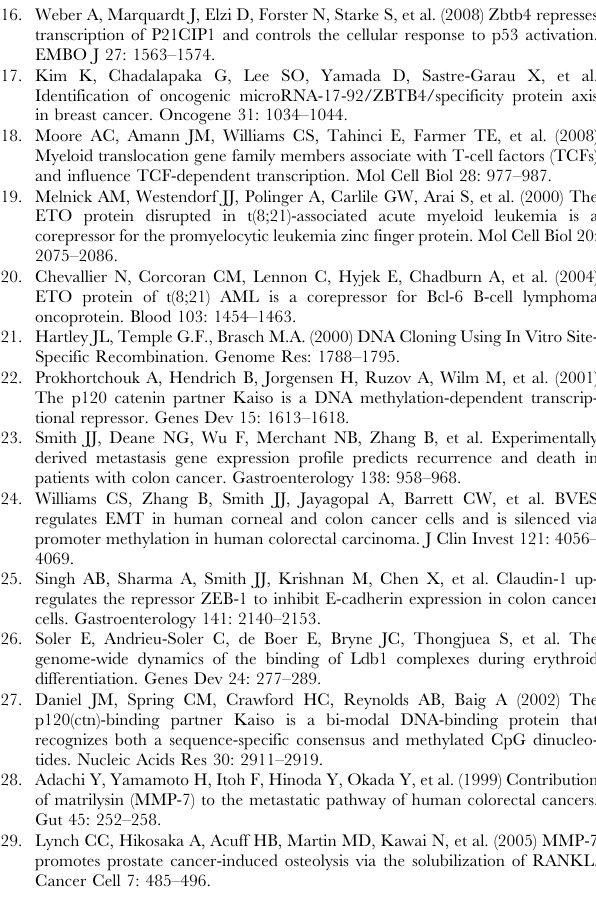
control. The graph shows the fold-change in luciferase activity relative to the standard pGL4-TK hRLUC after transfection of expression plasmids. The error bars represent the standard error of four replicate experiments performed in triplicate. * P , 0.05, Figure S5 Established MTG8 and MTG16 colorectal cancer mutations do not alter repression of Kaiso target promoters. A. 4 6 KBS artificial promoter assays in HCT116 cells. The graph shows the fold-change in luciferase activity relative to the standard pGL4-TK hRLUC after transfection of expression plasmids encoding the indicated MTG8 mutant constructs. B. HMAT-2.3 artificial promoter assays in HCT116 cells. The graph shows the fold-change in luciferase activity relative to the standard pGL4-TK hRLUC after transfection of expression plasmids encoding the indicated MTG8 mutant constructs. The error bars represent the standard error of three replicate experiments performed in triplicate. * P , 0.05, ** P , 0.01. (TIF) Figure S6 HT29 cells express higher levels of MMP-7 and lower levels of MTG16 than other colon cancer cell lines. A. MTG16 , B. MMP-7 , and C. Kaiso mRNA expression in colon cancer cell lines. The graph shows the fold-change ( DD Ct) of mRNA. Error bars represent the standard error for three replicate experiments performed in triplicate. (TIF)